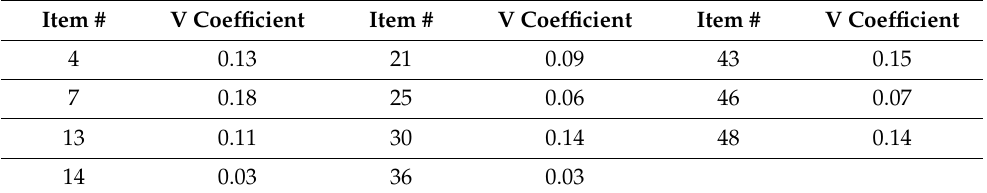
Table 5. Items Assessing Taekwondo Athletes’ Sport Psychological